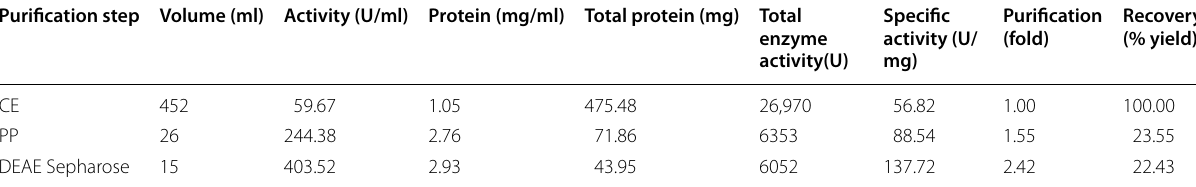
CE: Crude enzyme; PP: protein precipitate (dialysate)